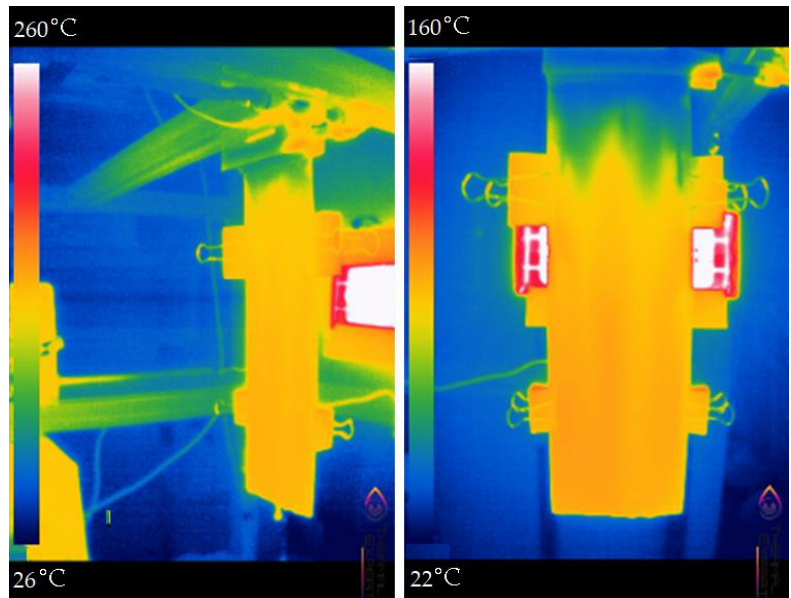
Figure 3. The surface area of liquid spreading over plastic with a polymer mesh flow divider. It can be seen that, in this configuration, almost the entire evaporating surface will be covered with the treated liquid.